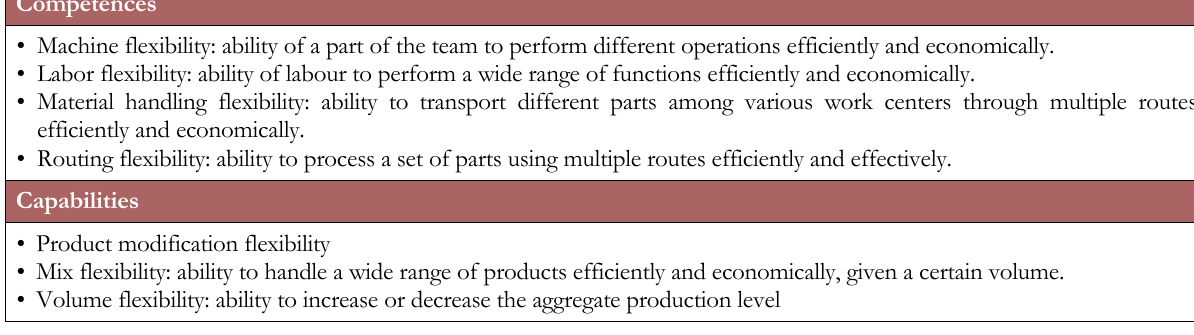
Table 2. Competences and capabilities for Manufacturing flexibility dimensions (Zhang et al.,